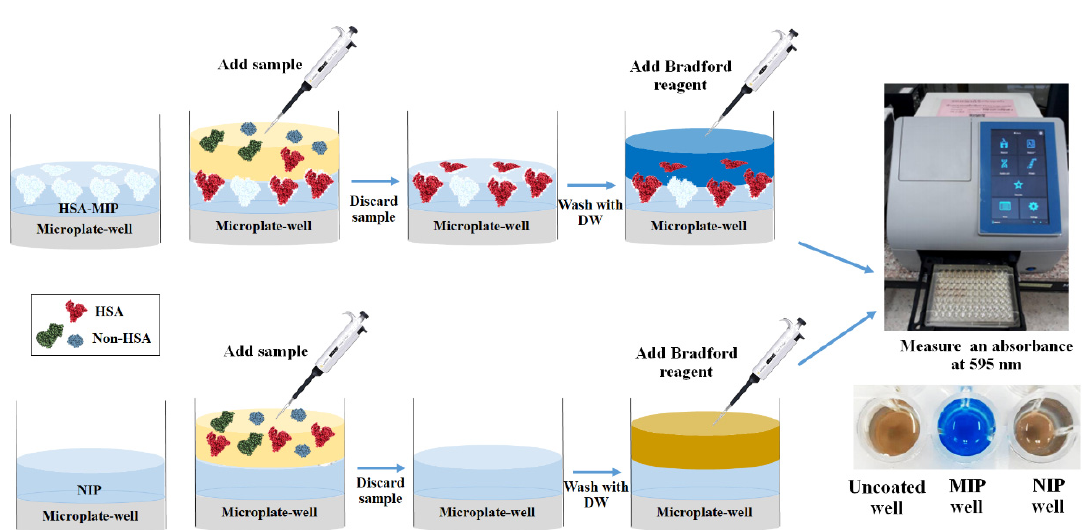
Figure 2. Schematic diagram of HSA determination with the MIP-based microplate assay.